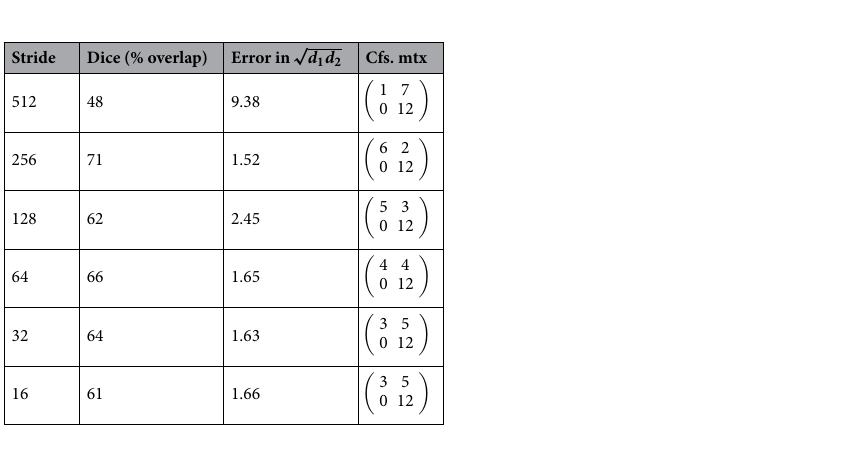
Table 6. The effect of sliding window tile stride on slide-level tasks using the EfficientNet-B3 architecture. In all experiments, we use K-means negative sampling and only random cropping as data augmentation.